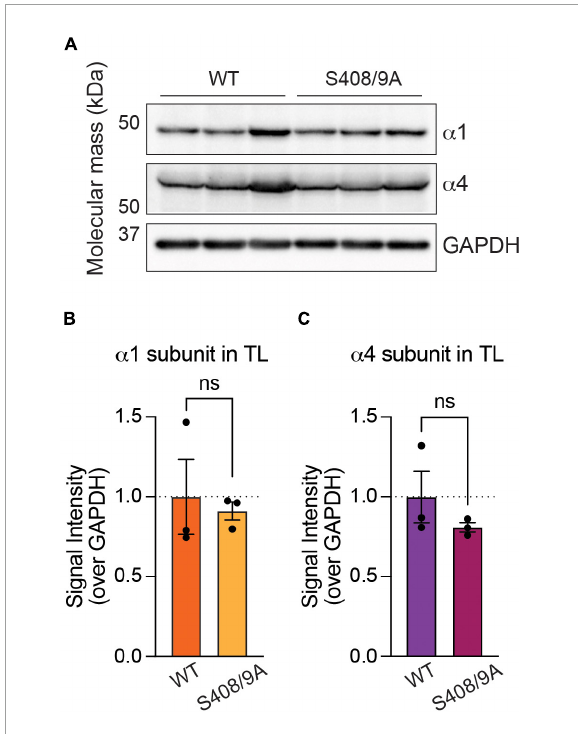
FIGURE5 Mutation of S408/9 does not change the total expression level of the α 1 or α 4 subunit. (A) Immunoblots of forebrain tissues from WT and S408/9A mice were probed for the α 1 subunit, α 4 subunit, and GAPDH. (B) Signal intensity of the α 1 subunit was normalized to that of GAPDH. There is no significant change in the total level of the α 1 subunit in the forebrain between WT and S408/9A mice (ns ≥ 0.05, n = 3). (C) The S408/9A mutation does not affect the total level of the α 4 subunit in the forebrain (ns ≥ 0.05, n =